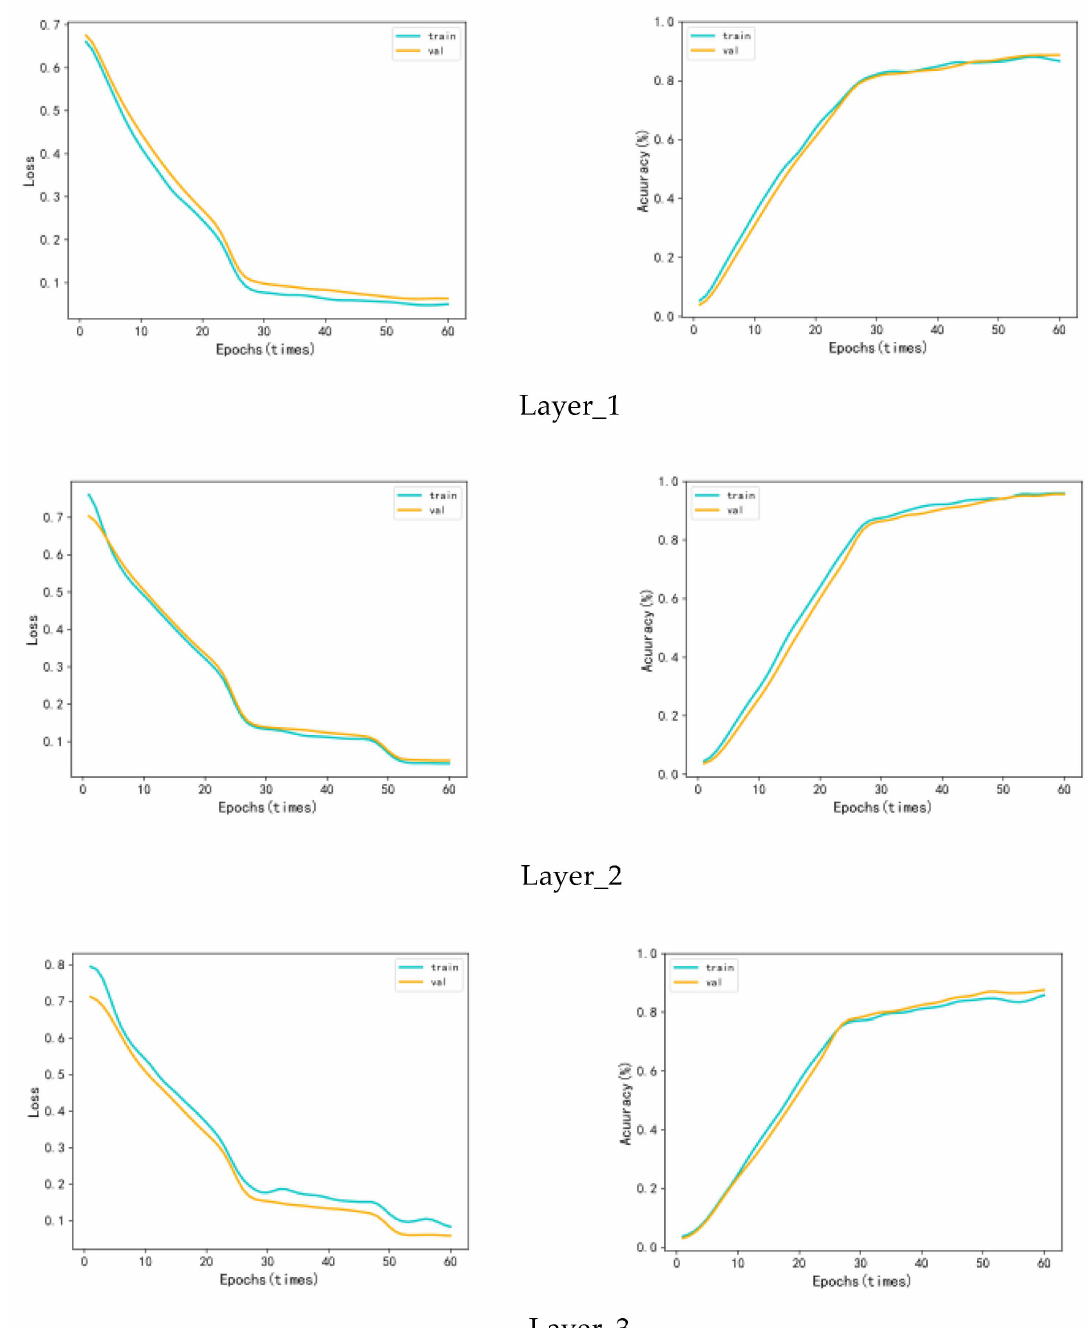
Figure 15. The training effect of Bi-GRU with different numbers of